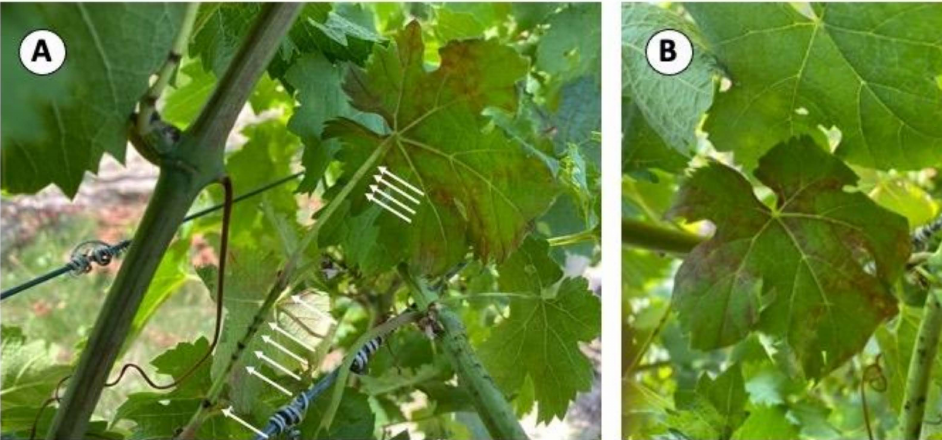
Figure 4. Girdles and foliar reddening observed after Spissistilus festinus feeding on ‘Cabernet franc’ grapevine tissue in New York. Utilizing the tootsie roll sleeve configuration, 20 viruliferous S. festinus were allowed to feed on the length of a shoot. Upon the removal of the insects, the number of girdles was observed, and foliar reddening was monitored for the remainder of the growing season. ( A ) Ten girdles indicated by the white arrows due to S. festinus feeding and reddening on the abaxial surface of the leaf resembling red blotch disease symptoms. ( B ) Foliar reddening observed on the adaxial surface of the leaf due to the 10 girdles resembling grapevine red blotch symptoms. Despite the observed reddening upon feeding by viruliferous S. festinus , GRBV was not present in the inoculated leaf when tested via multiplex